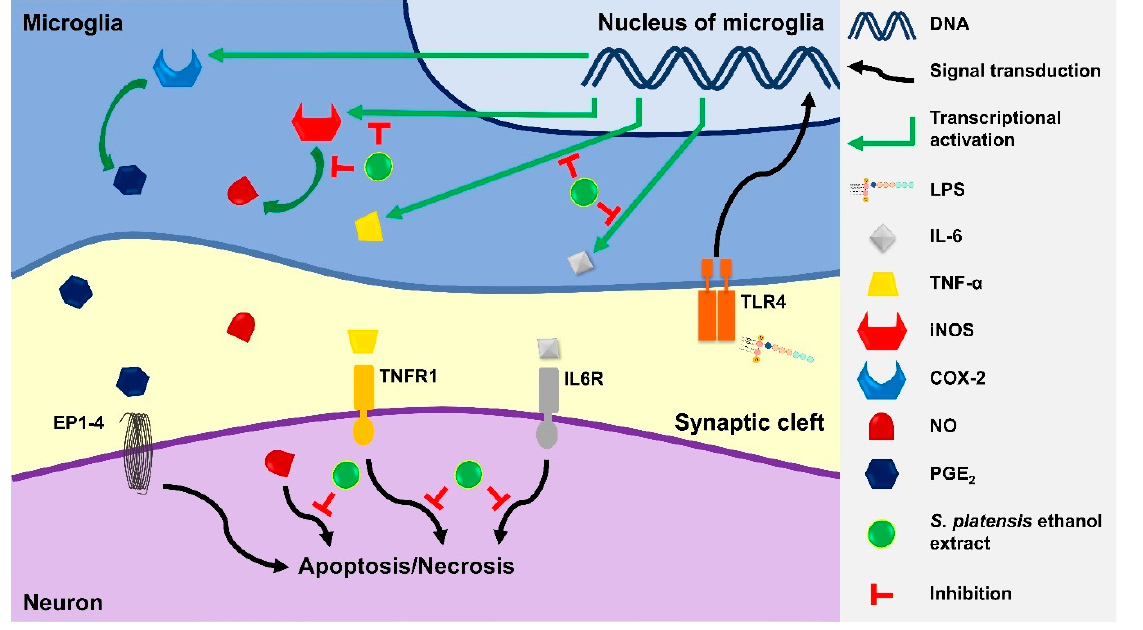
Figure 6. Illustration of neuroprotective effect by S. platensis ethanol extract via downregulation of the LPS-induced production of proinflammatory mediators and cytokines in BV2 microglia. TLR4: Toll-like receptor 4; EP1-4: Prostaglandin E2 receptor 1-4; TNFR1: Tumor necrosis factor receptor 1; IL6R: Interleukin 6 receptor.